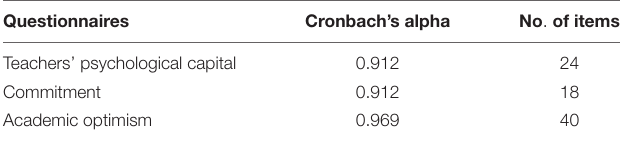
TABLE 1 | Reliability of the questionnaires.